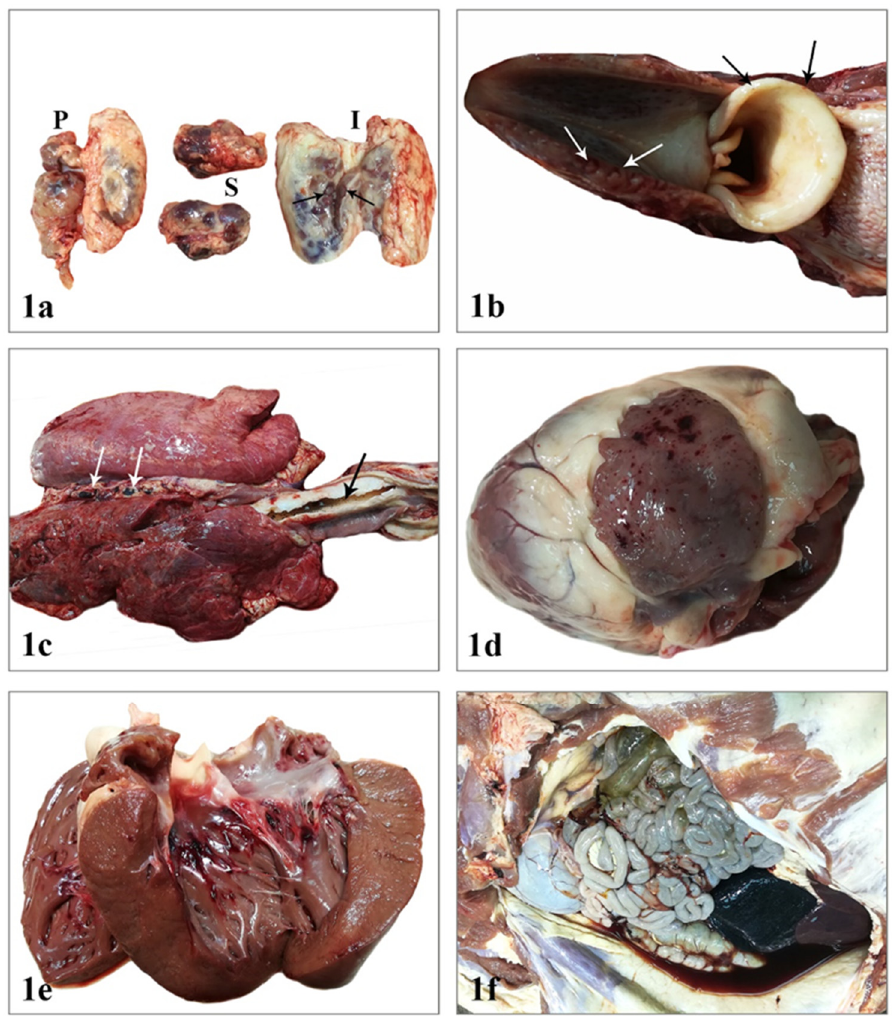
Figure 1. ( a ). Enlarged superficial cervical (prescapular) (P), submandibular (S), and inguinal (I) lymph nodes. The submandibular lymph nodes appear also diffusely hyperemic and the inguinal on the cut surface are characterized by hemorrhage at the periphery of lymphoid follicles, probably in the marginal zone (arrows). ( b ). A few petechiae are observed on the epiglottis (black arrows), the tonsils are mildly enlarged and on the cut surface are shown formations similar to those described in Figure 1a for inguinal lymph nodes (white arrows). ( c ). The right lung architecture is locally distorted because of fibrosis and the presence of symphysis between visceral and parietal pleura. Lungs are diffusely hyperemic and frothy material (pulmonary edema) occupies the tracheal lumen (black arrow). The caudal mediastinal lymph nodes are hemorrhagic (white arrows). ( d ). Multiple subepicardial petechial and ecchymotic hemorrhages are noted in the right auricle of the heart. ( e ). Hemorrhages are located mostly in the subendocardium of the left ventricle. ( f ). The peritoneal cavity bears serosanguineous content with a few filaments of fibrin. The spleen is discernible on the right side of the abdomen due to enlargement and presents dark red to black color.